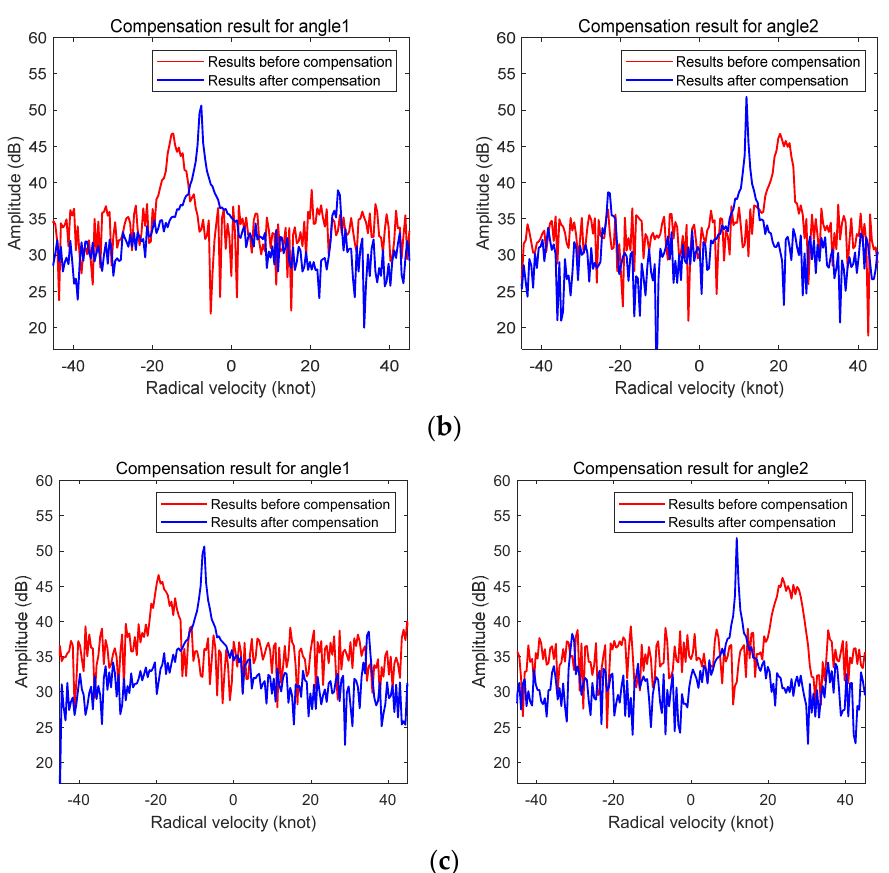
Figure 14. Compensation result for the case of uniform yaw motion: ( a ) when ship velocity is 5 knots, ( b ) when ship velocity is 15 knots, ( c ) when ship velocity is 15 knots.